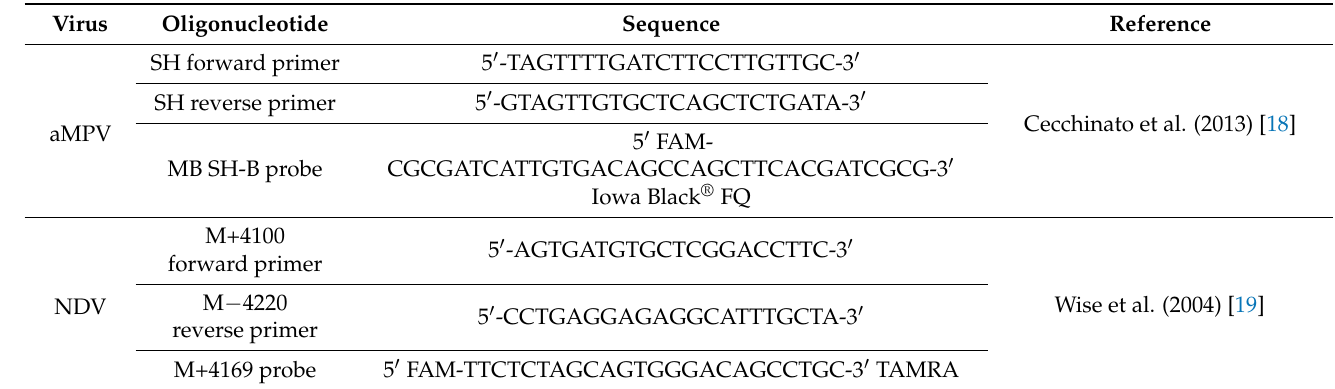
Table 1. Primers and probes used in the real-time RT-PCR assays for the detection and quantification of aMPV and the detection of